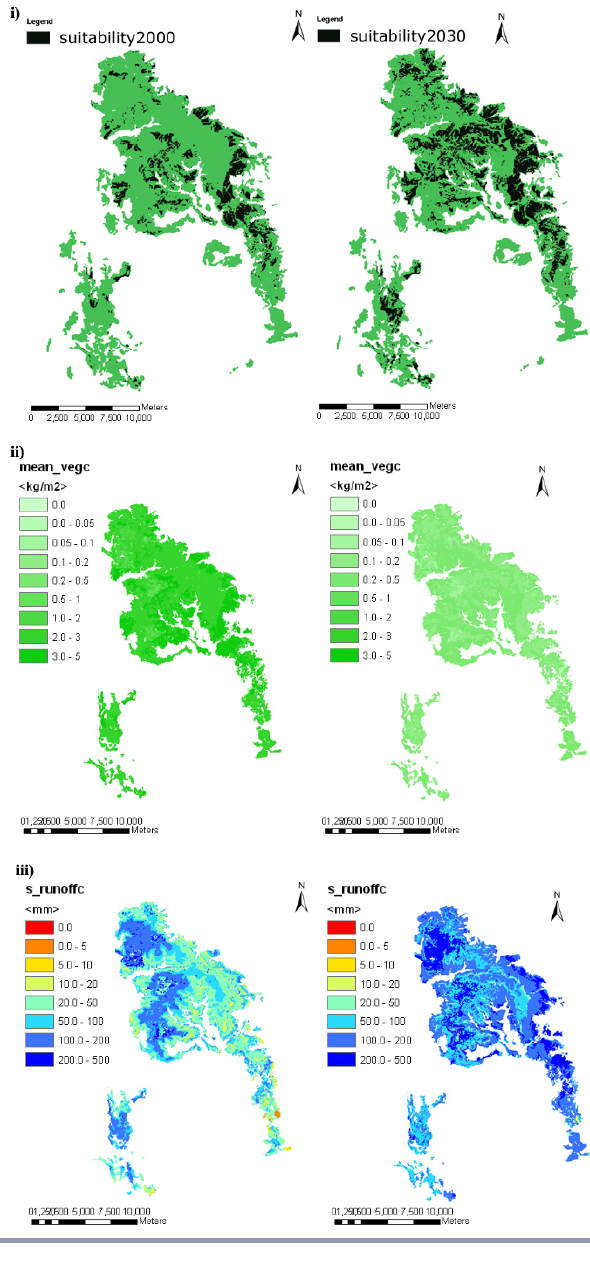
Fig. 6 . Changes in area of land suitable for arable agriculture, annual runoff, and vegetation cover under the “food secure future” scenario, showing (i) Dark Peak uplands suitable for arable agriculture in 2000 and 2030; (ii) vegetation biomass in 2009 and 2030 showing 10% of potential biomass in 2030; and (iii) annual runoff in 2009 and